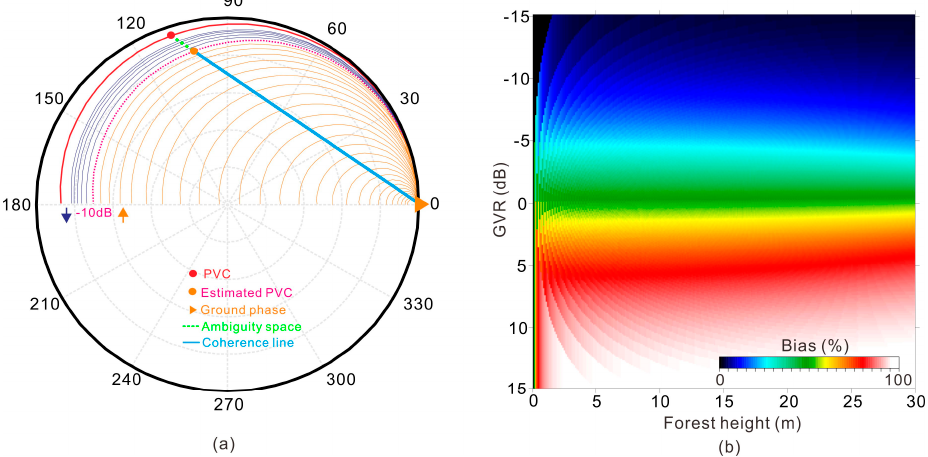
Figure 2. ( a ) Representation of interferometric coherence sets in complex plane for different GVRs; and ( b ) bias of the forest heights under the null GVR assumption.